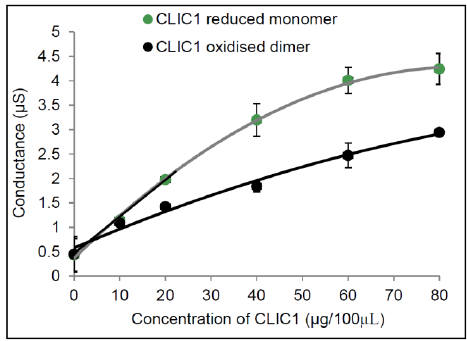
Figure 2. Conductance of different concentrations of CLIC1 in tBLMs containing 25 mol % cholesterol. Concentrations of 0, 10, 20, 40 and 60 µg of CLIC1 reduced monomer (pre-incubated with 0.5 mM TCEP) and CLIC1 oxidised dimer (pre-incubated with H 2 O 2 ) in 100 µL of HEPES/KCl buffer (pH 6.5) were added into membranes containing 25 mol % cholesterol where the conductance was measured and linear fitting (as indicated in black for CLIC1 reduced monomer and red for oxidised dimeric CLIC1) and quadratic polynomial fits were generated using Microsoft Excel 2010 ( y = −0.0005 x 2 + 0.0924 x + 0.3639, R 2 = 0.9985 for CLIC1 monomer and y = −0.0001 x 2 + 0.0399 x + 0.5761, R 2 = 0.9857). The error bars represent the standard error of three experimental repeats ( n = 3).